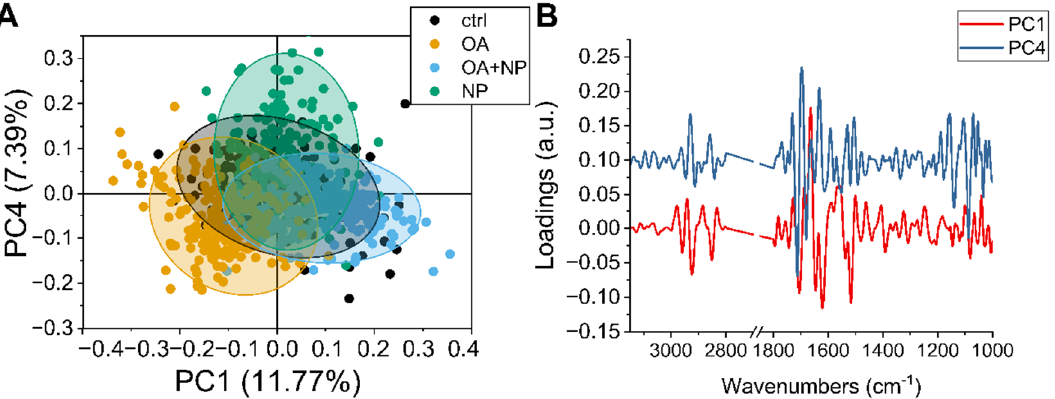
Figure 6. ( A ) Scatter plot of principal component analysis (PCA) scores of principal component (PC)1 and PC4. ( B ) Line plot of charge vectors corresponding to PC1 (in black) and PC4 (in red). For clarity, an offset of 0.1 a.u. was added to the y-axis.